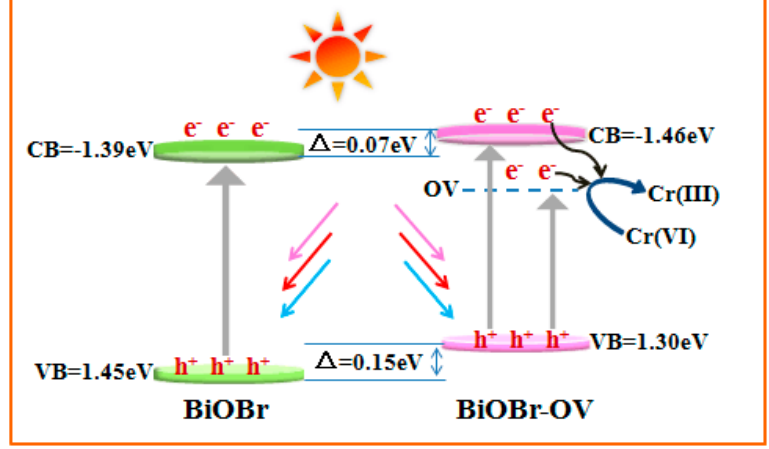
Figure 9. Schematic representation of photoreduction mechanism for Cr(VI).